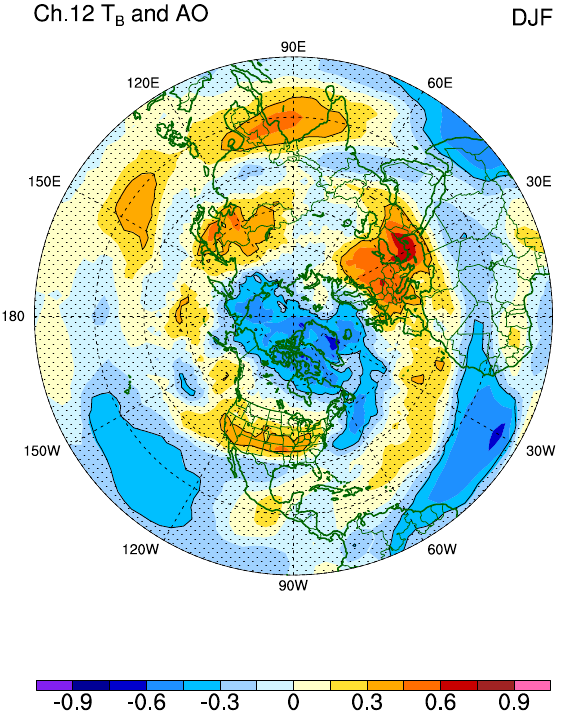
Fig. 10. Same as Fig. 7 for correlations between channel 12 T B and NAO index.